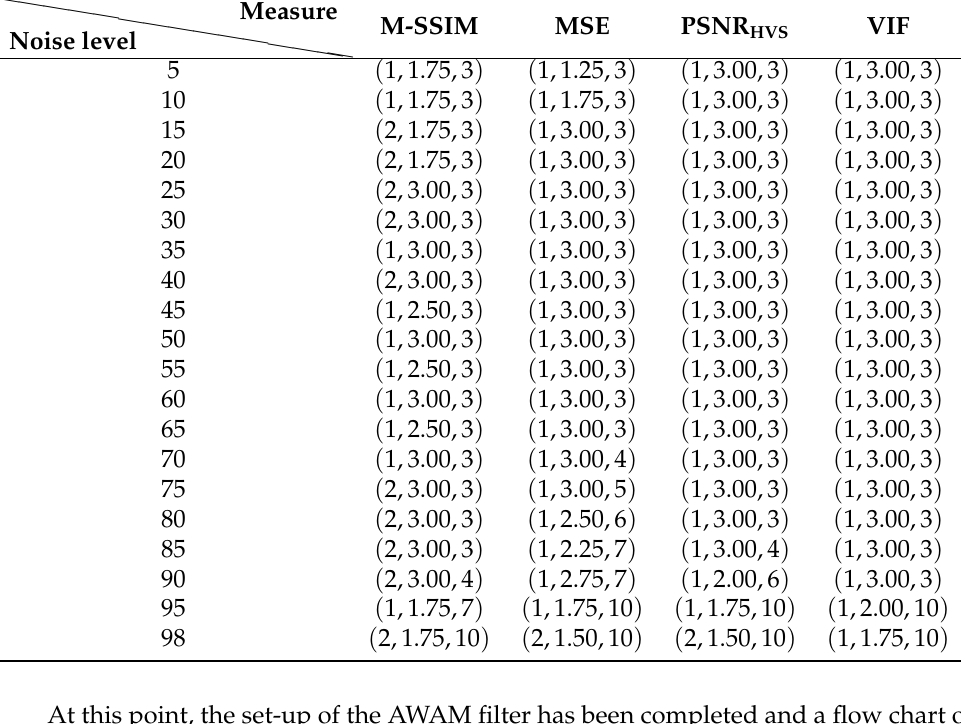
Table 1. Best parameters values d , β and n for each noise level according to the considered measures.